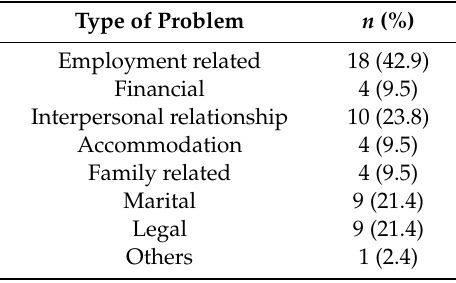
Table 3. DSM-IV Axis IV diagnosis among the study subjects.